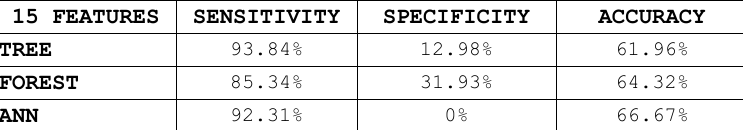
Table 7. PCA Pixel value metrics.